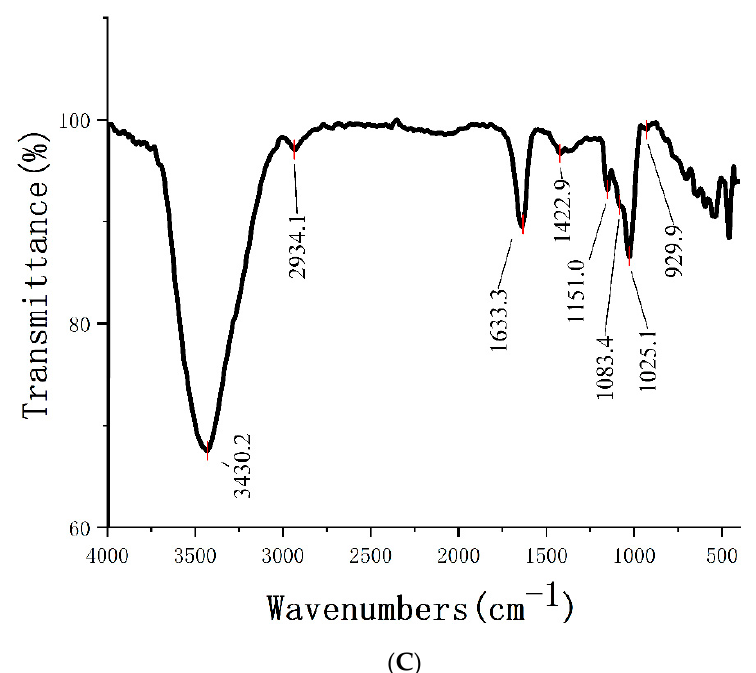
Figure 1. ( A ) Molecular weight determination, ( B ) Log–log plot of r g versus Mw; RMS—root mean square; ( C ) FT-IR spectrum of GEP-1.